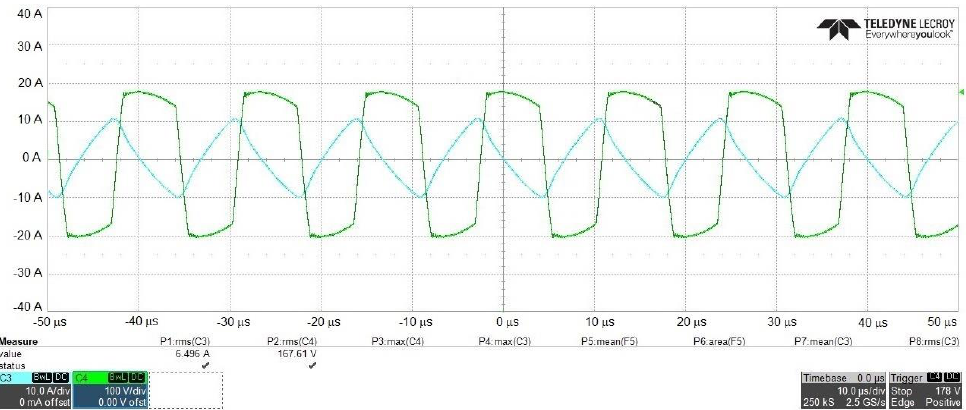
Figure 24. Transmitter coil voltage (C4, green) and current (C3, blue) at 75 kHz.